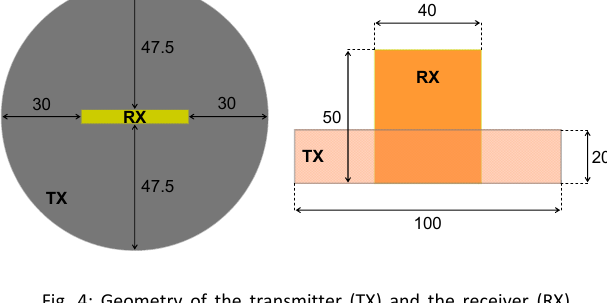
Fig. 4: Geometry of the transmitter (TX) and the receiver (RX) forming the transceiver. Left: front view, right: top view. All dimensions are given in [mm].